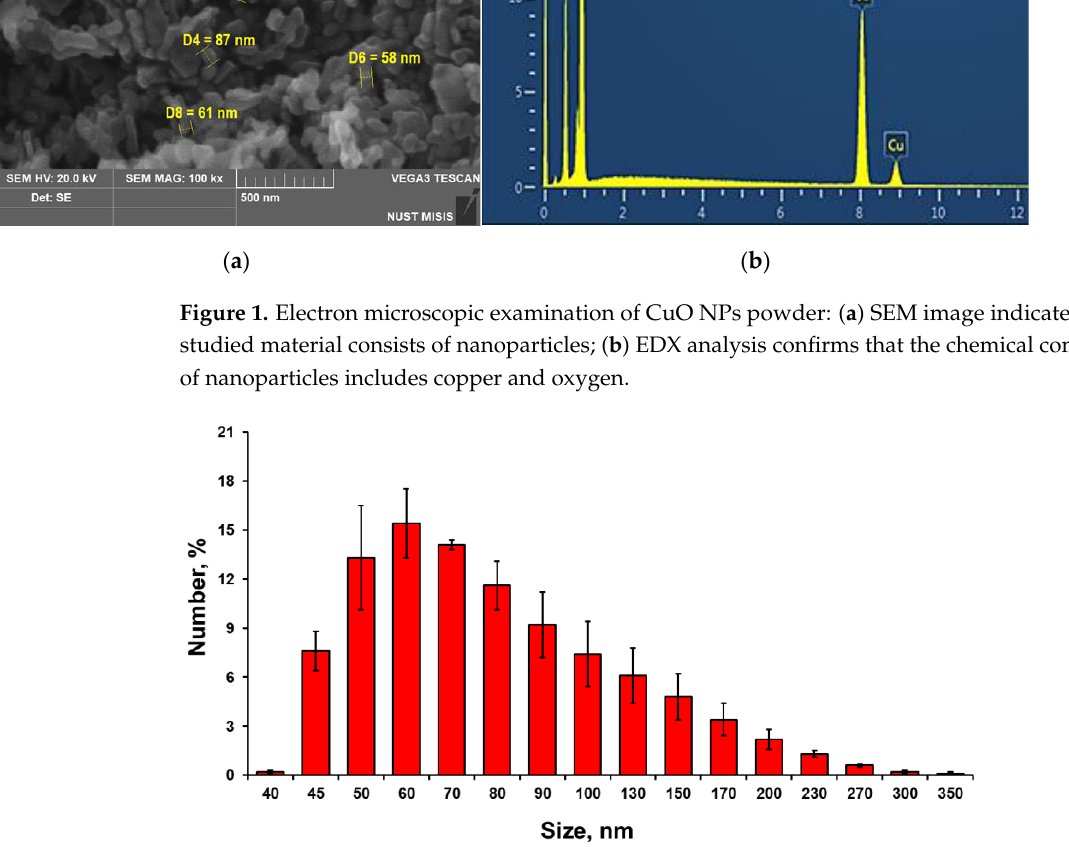
Figure 2. Dispersed composition of CuO NPs suspension (1 g/L) confirms that the particles in suspension have nanometer sizes.